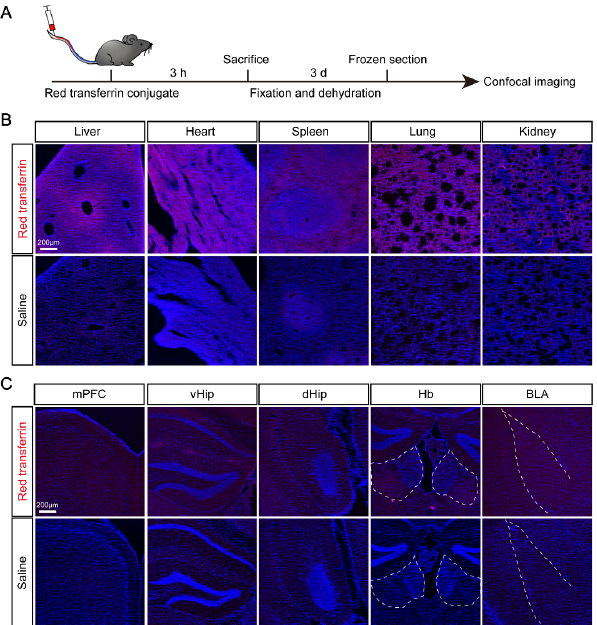
level, indicating the upregulated expression of TF in the brain might be contributed by both local transcription and circulated TF from peripheral tissues through BBB.